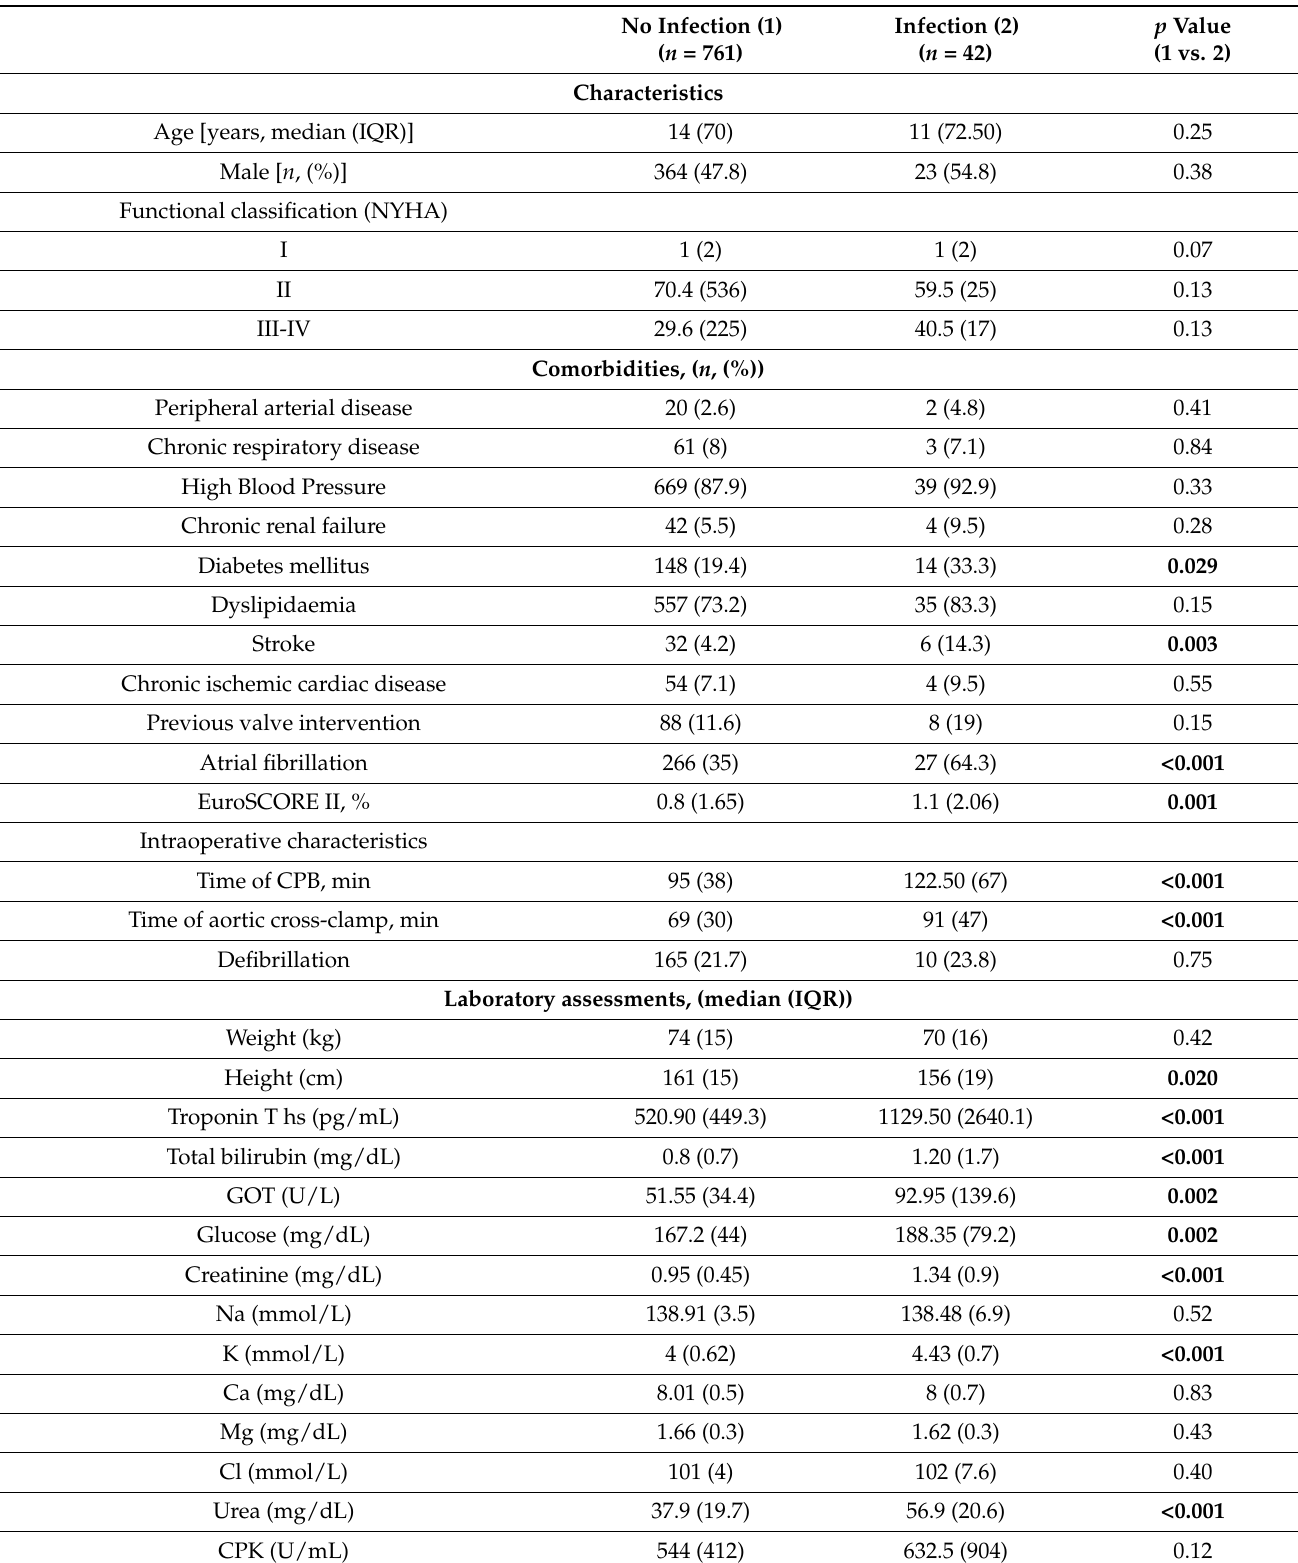
Table 1. Characteristics of the patients in the infection and non-infection groups. Continuous variables are represented as median and interquartile range (IQR); categorical variables are represented as number ( n ) and percentages (%). ICU: intensive care unit; SOFA: Sequential Organ Failure Assessment Score; INR: international normalised ratio. p values < 0.05 are highlighted in